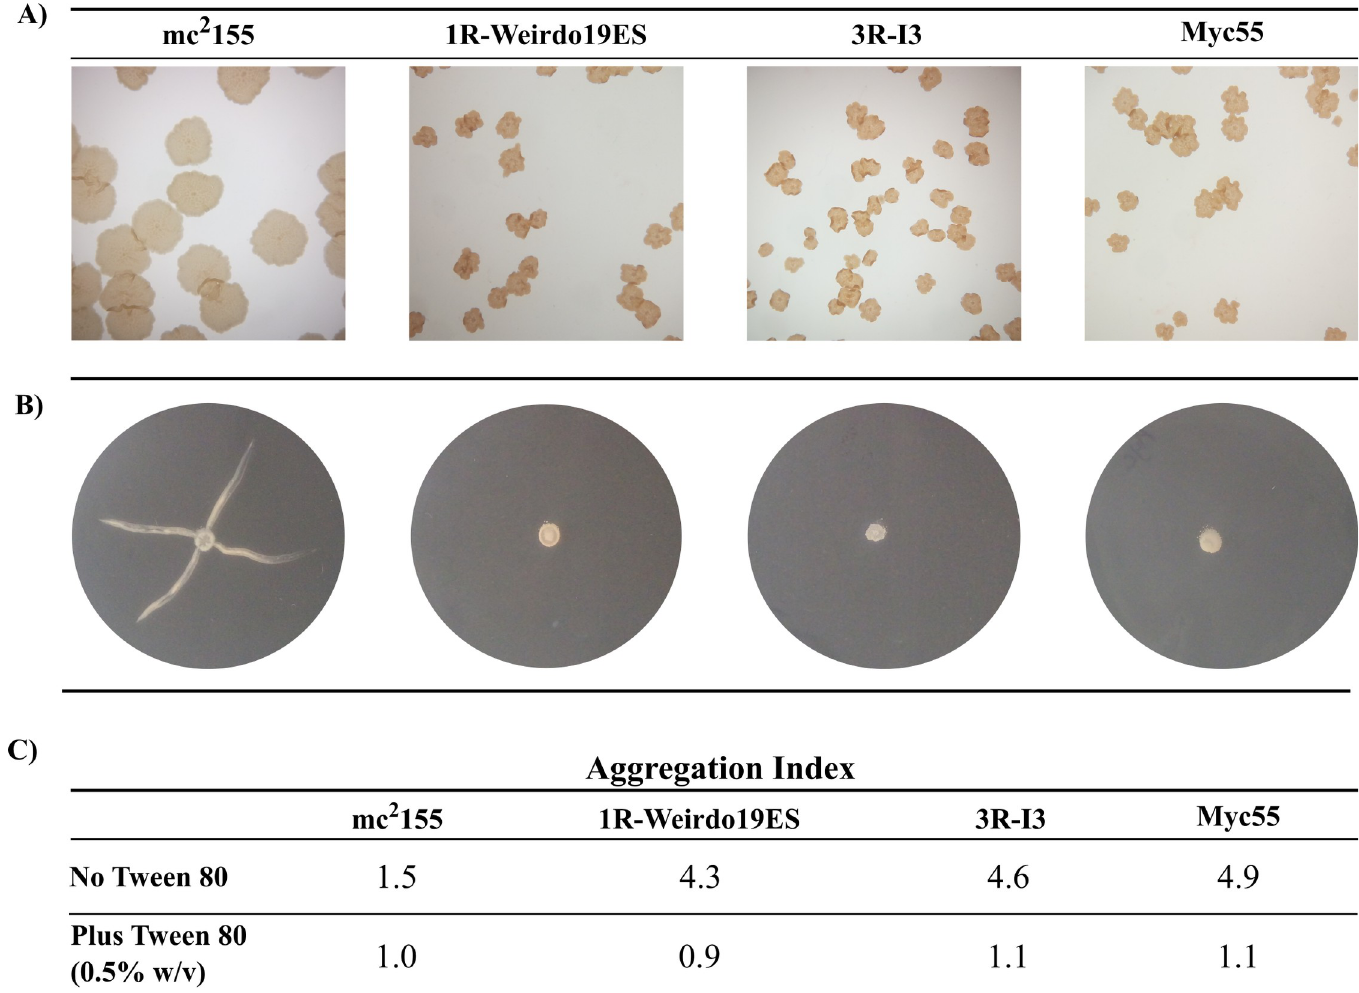
Fig 9. Phage resistant mutants of Mycobacterium smegmatis . The mutant strains (1R-Weirdo19ES, resistant to mycobacteriophage Weirdo19ES; 3R-I3, resistant to mycobacteriophage I3 or Myc 55 share colony morphology (Panel A), sliding motility behavior (Panel B) and cell aggregation (Panel C). Panel A: Aliquots containing 10 2 CFU of each strain were spread onto solid medium plates containing Congo Red (100 μ g ml-1). Growth was examined under microscope at 8X magnification after 3 days of incubation at 37˚C. Pictures are representative of ten fields observed for each plate. Panel B: 5 μ l drops of a stationary culture of each strain were placed in the center of 0.3% (w/v) agar plates, the plates were sealed with Parafilm and incubated for 7 days at 37˚C. Panel C: Aggregation Index for each strain was determined in the absence or presence of 0.5% (w/w) Tween 80 as described in Materials and Methods.